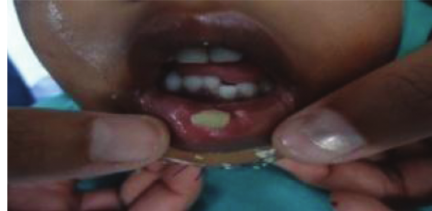
Figure 1: Preoperative photograph showing symphysis fracture.